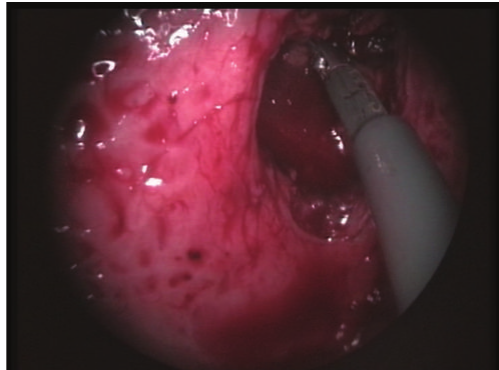
Figure 4: The mobilized distal ureter is placed outside the bladder. The bladder defect will be closed with running